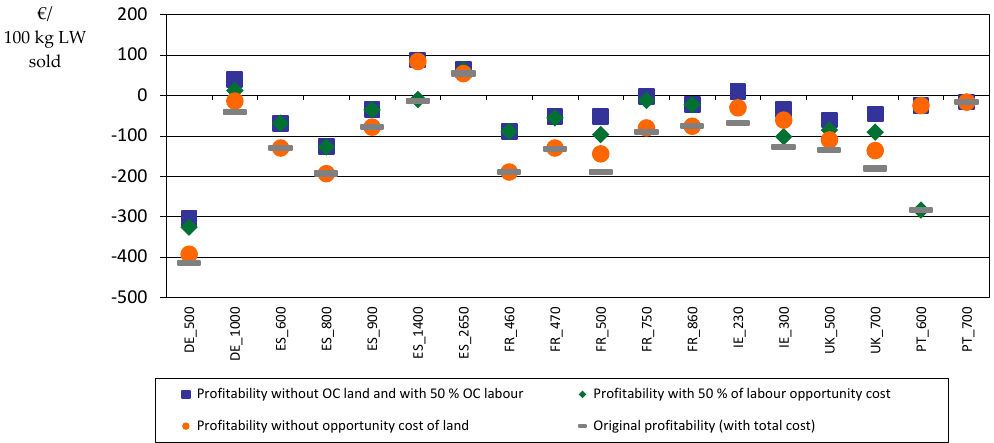
Figure 12. Profitability with variations in opportunity costs (€/100 kg LW sold). Source: model results.